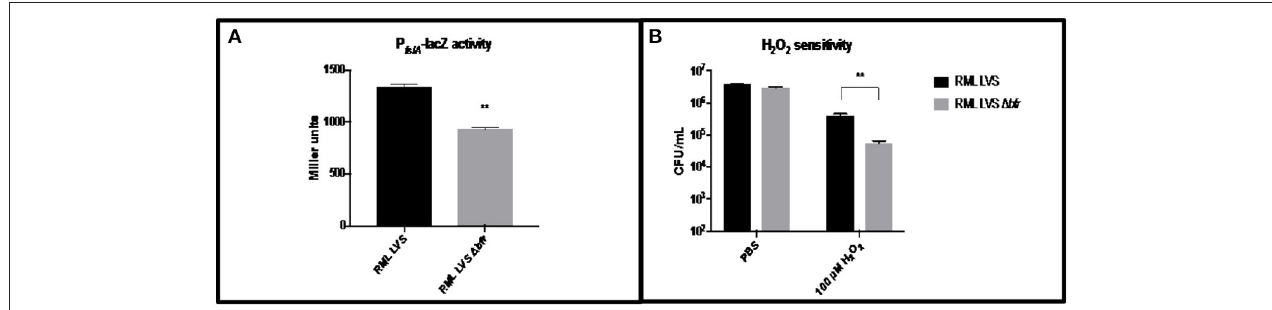
FIGURE 4 | Iron related phenotypes of RML LVS 1 bfr . (A) P fslA -lacZ reporter activity is decreased in the RML LVS relative to wild type. Welch’s t -test was used to test for significance. Shown is a representative of five replicates. (B) The RML LVS 1 bfr is more sensitive to H 2 O 2 killing than the wild type. A two-way ANOVA with Sidak’s multiple comparisons test was used to test for significance. Significance was set at p < 0.05. **Indicates a significant difference between the samples indicated. Shown is a representative of four